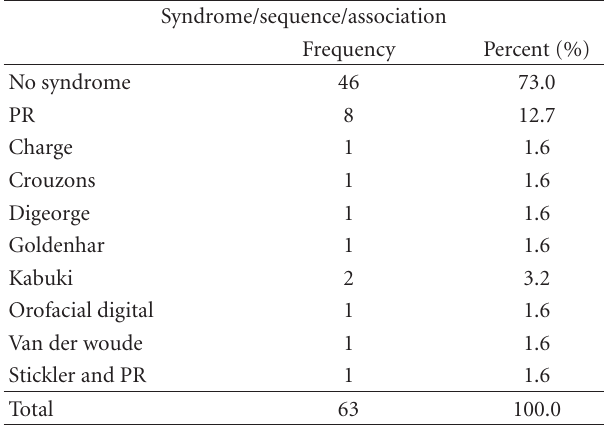
Table 6: Associated syndromes, associations and nonrandom anomalies. PR: Pierre Robin sequence.